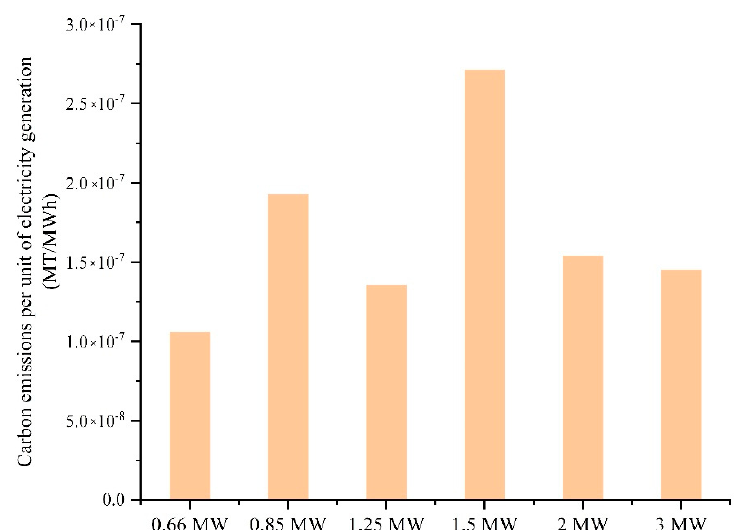
Figure 4. Comparison of carbon emissions of different types of wind turbines.